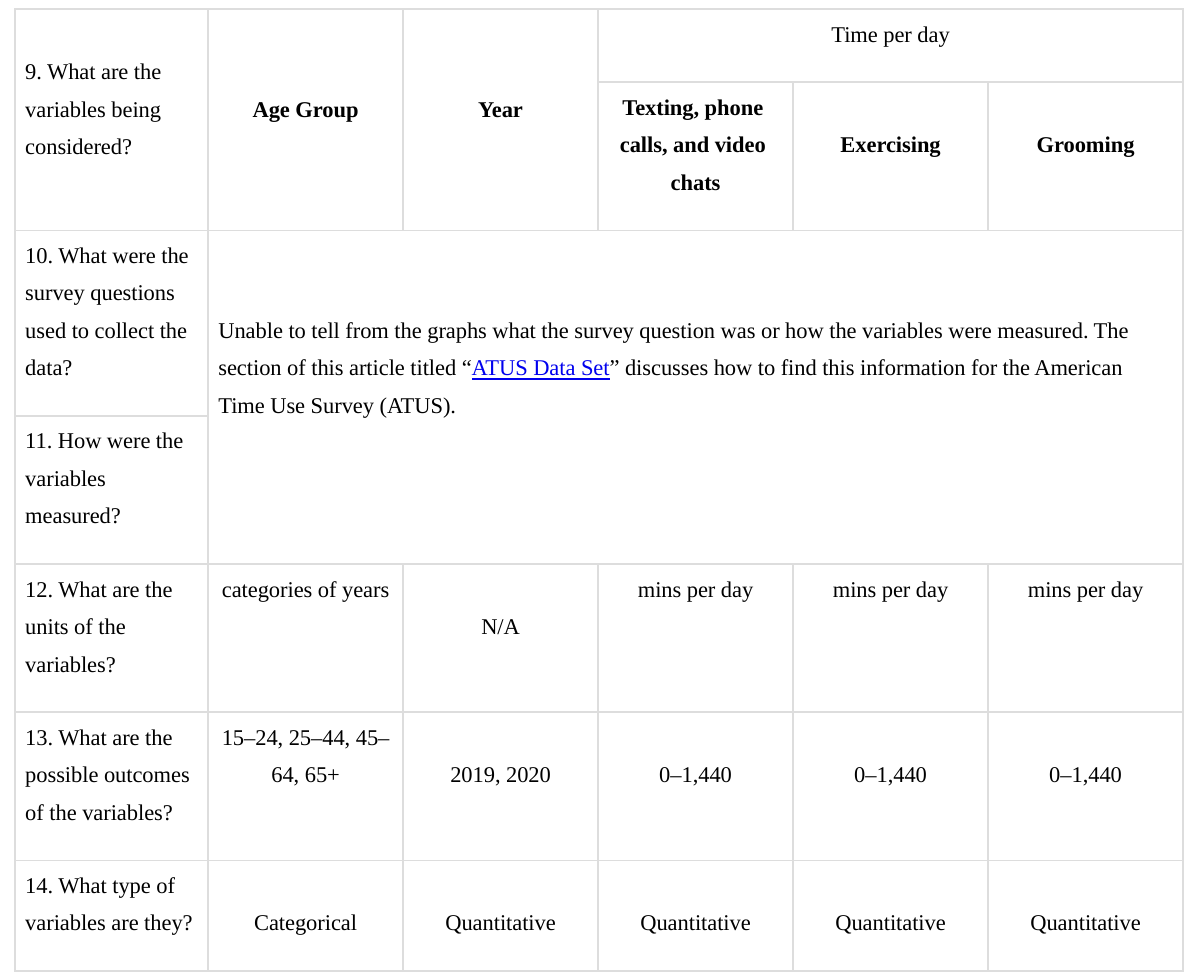
Table 1. Interrogating the variables in the data